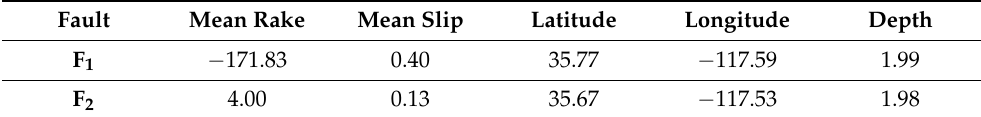
Figure 7. Curve representing tradeoff between model roughness and misfit. Red star indicates optimal smoothing parameter. Table 4. California earthquake inversion